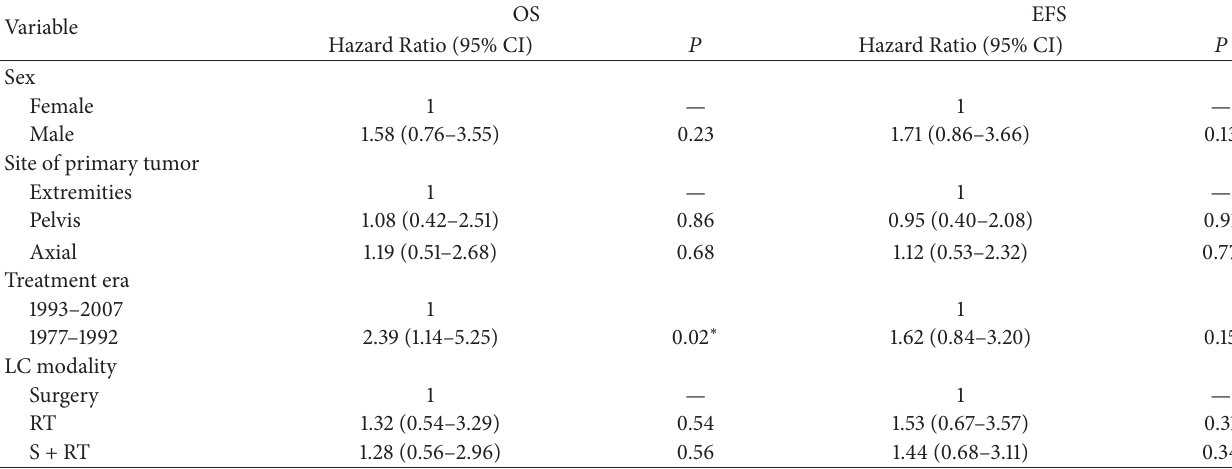
Table 3: Multivariate analysis for overall (OS) and event-free survival (EFS) ( 𝑛 = 102